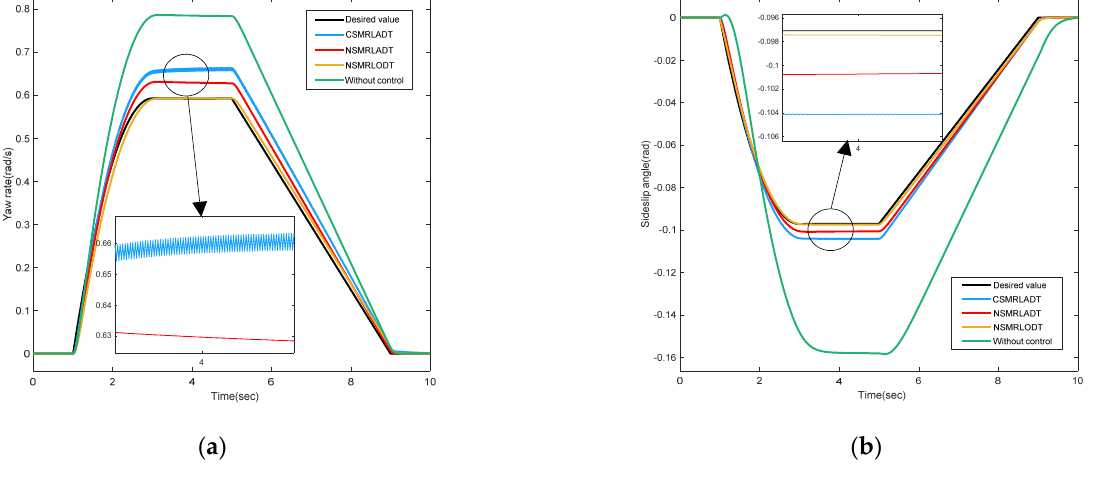
Figure 9. The curves of yaw rate and sideslip angle under J-turn maneuver. ( a ) Yaw rate; ( b ) sideslip angle.